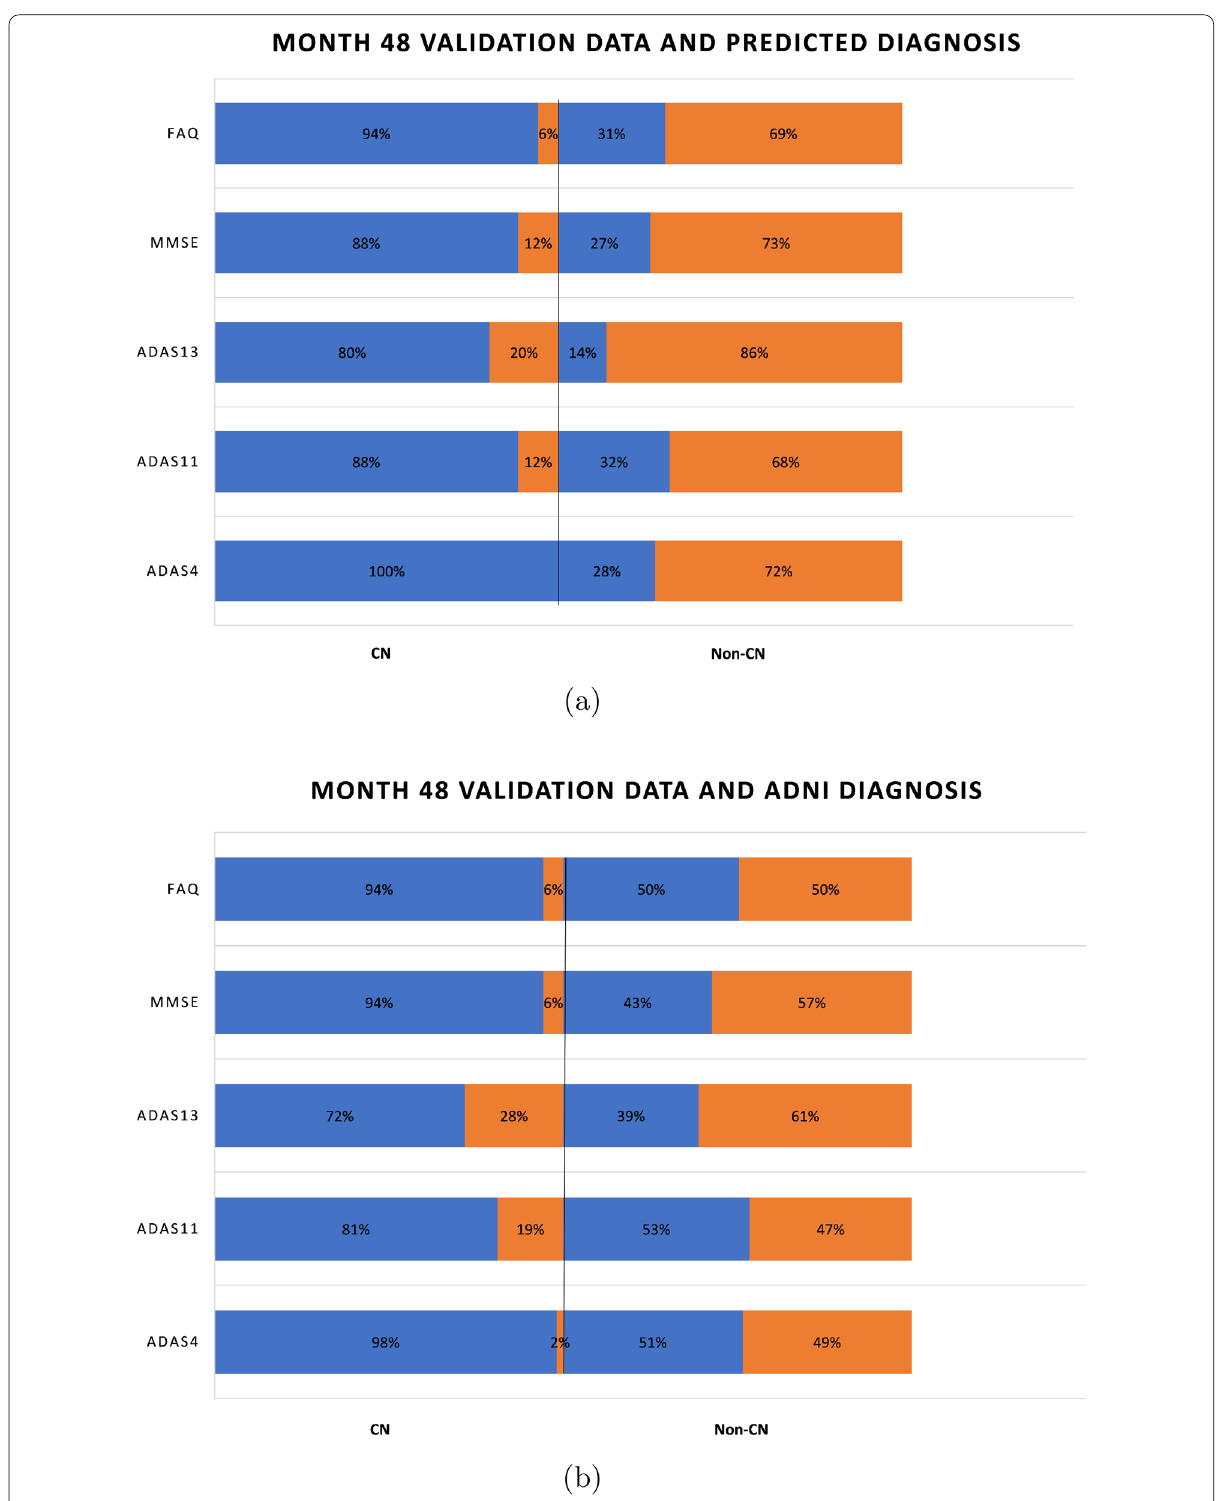
Fig. 6 Proportion of correct and incorrect diagnosis in CN and non-CN categories for validation data at month